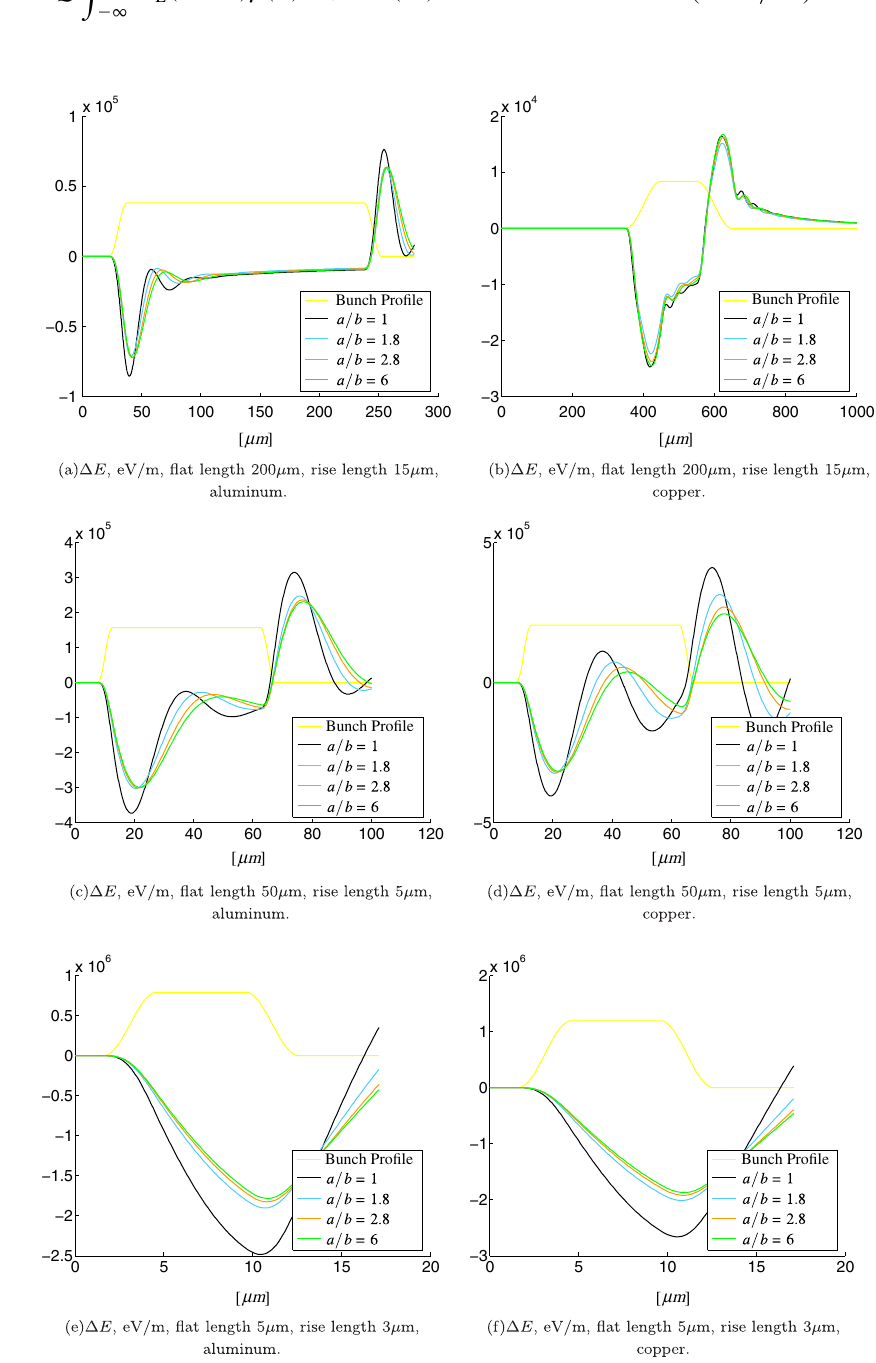
FIG. 8. (Color) Energy variation per unit length induced within flattop bunches with different lengths and charge of 1 nC. Semiminor axis b (cid:4) 3 mm , AC conductivity model, and several aspect ratio values a=b are